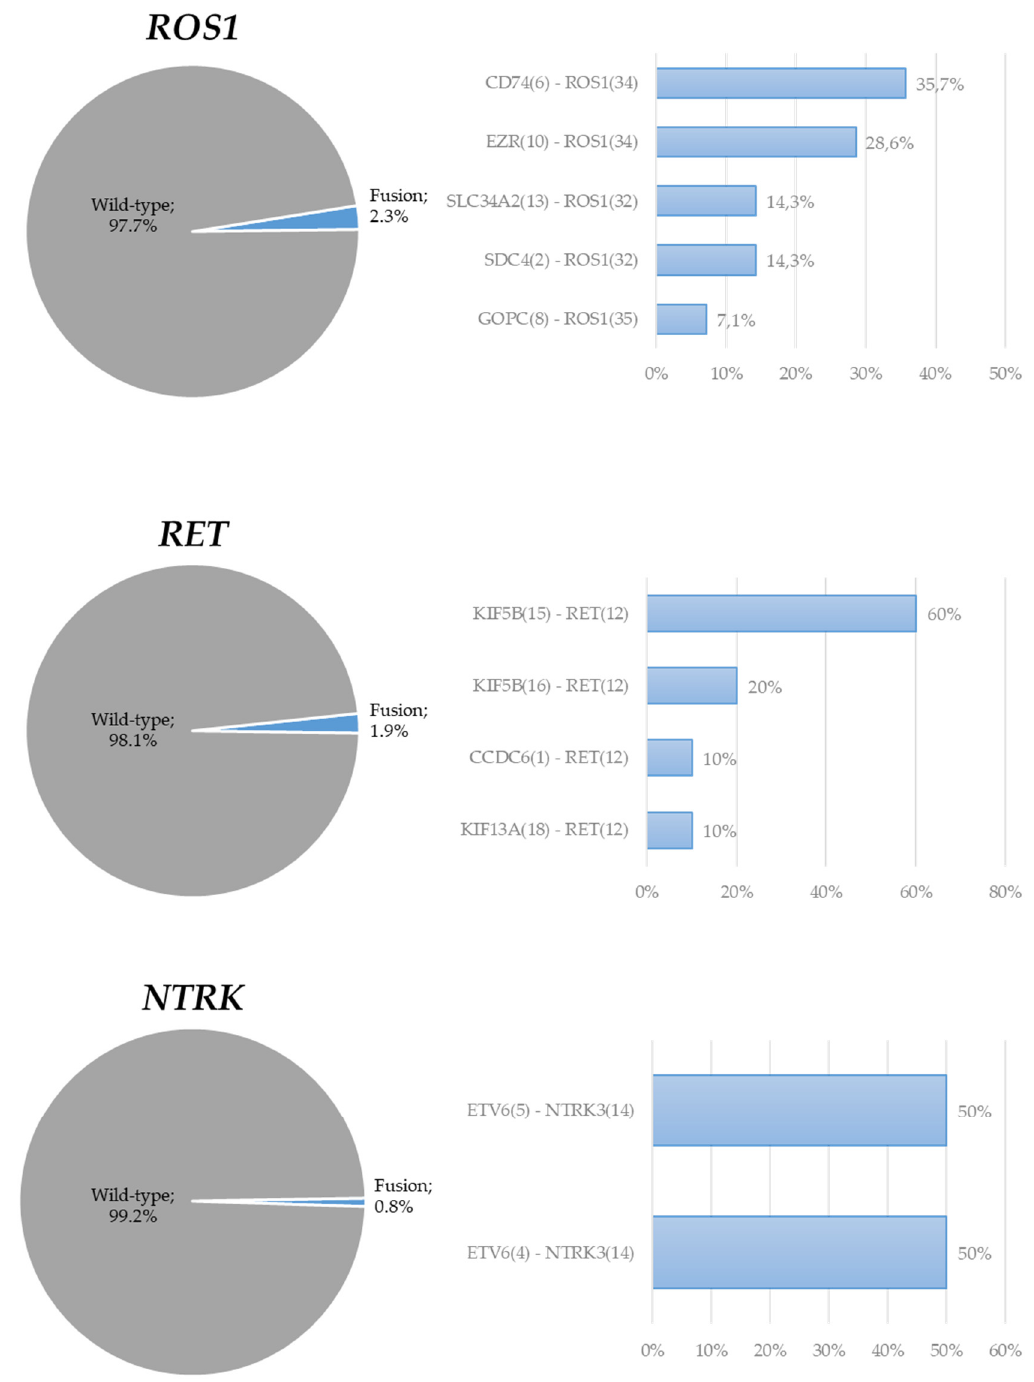
Figure 2. Distribution of driver molecular alterations detected in NS-NSCLC specimens during the study period.